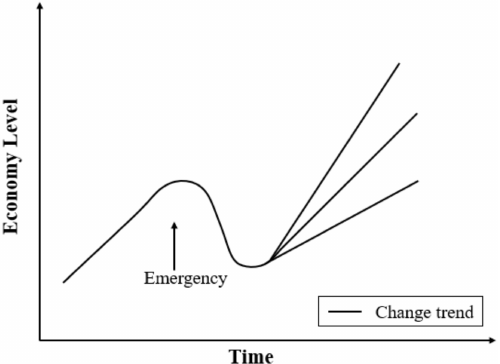
Figure 11. Impacts of an emergency shock on a city’s economy: (a) resumption of a unchangeable rate (pre-recession); (b) resumption of a sustained higher growth rate; (c) resumption of a sustained lower growth